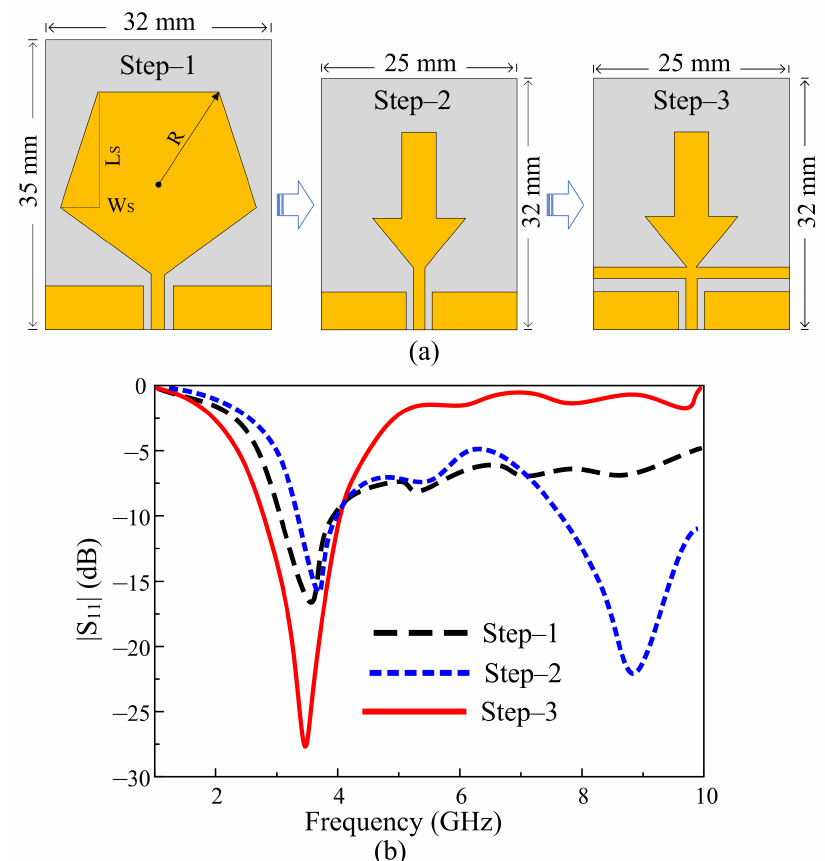
Figure 3. Design methodology of proposed filtenna. ( a ) Geometrical evolution. ( b ) |S 11 | for various design